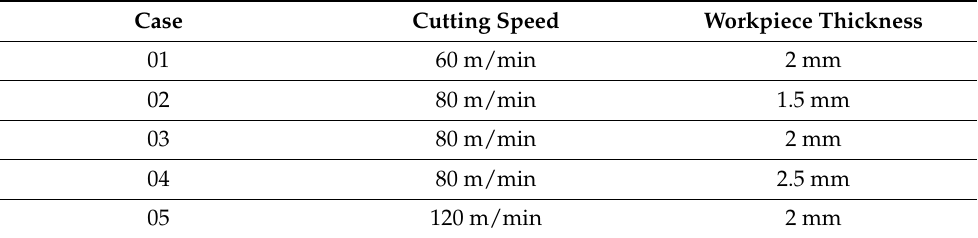
( b ) Figure 5. CAE model of thin-walled GH4169 workpiece with residual stress layer. ( a ) CAE model of the thin-walled workpiece; ( b ) layer affected by residual stress.